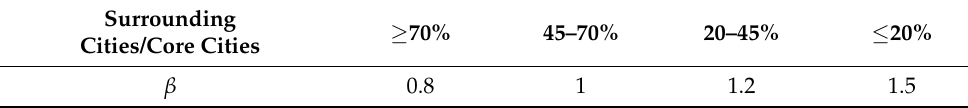
Table 3. The economic gap correction weight β .